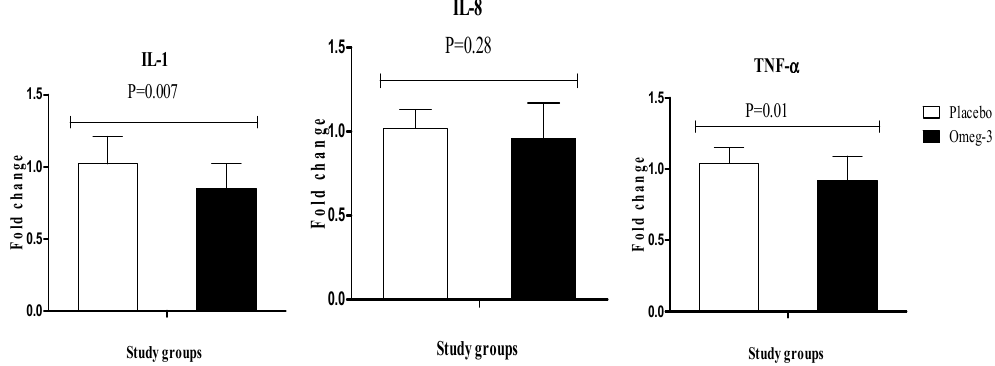
Figure 4. Effect of 6-week supplementation with omega-3 or placebo on expression ratio of IL-1, IL-8, and TNF- α gene in PBMCs of GDM women.